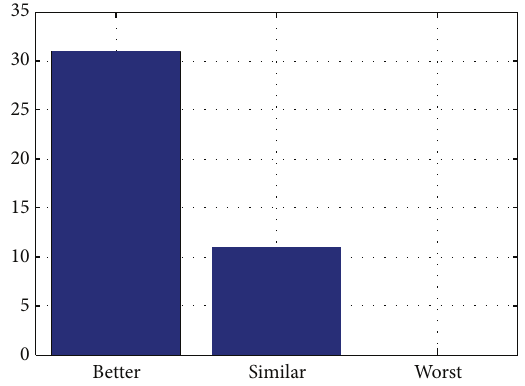
Figure 2: Performance comparison of EPDE1 and HSPEADE1.